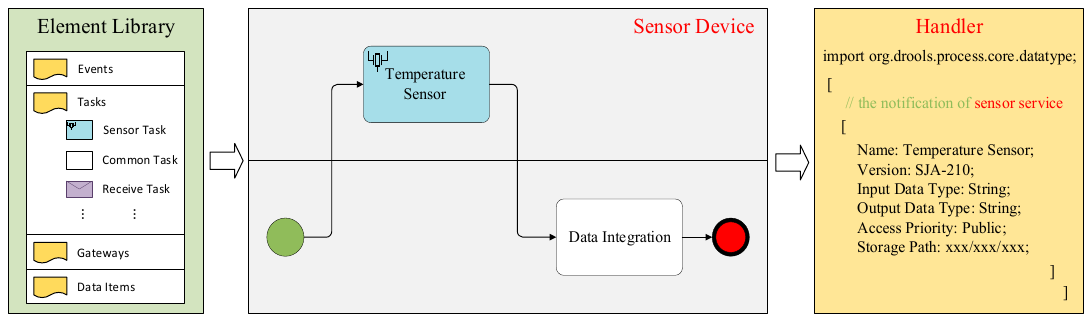
Figure 1. A business process model of the temperature perception associated application.